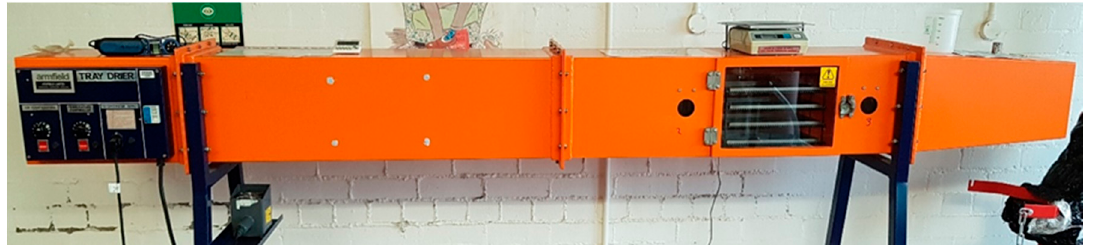
Figure 1. Tray drier working scheme and unit adopted in the experiment.